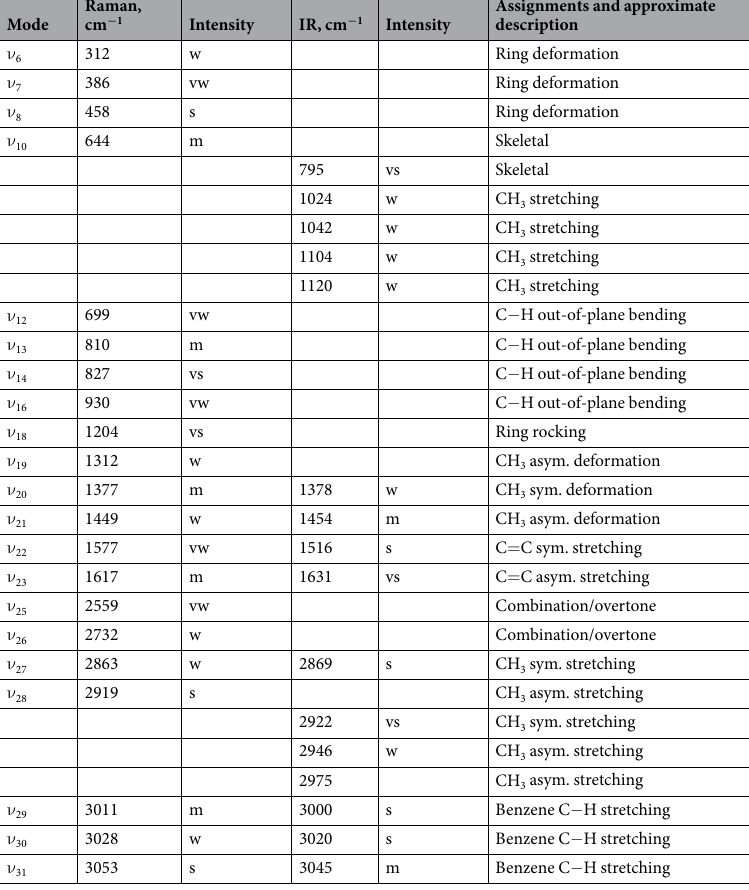
Table 1. The Raman and infrared spectrum and assignments for p -xylene under ambient conditions. vs : very strong; s : strong; m : medium; w : weak; vw : very